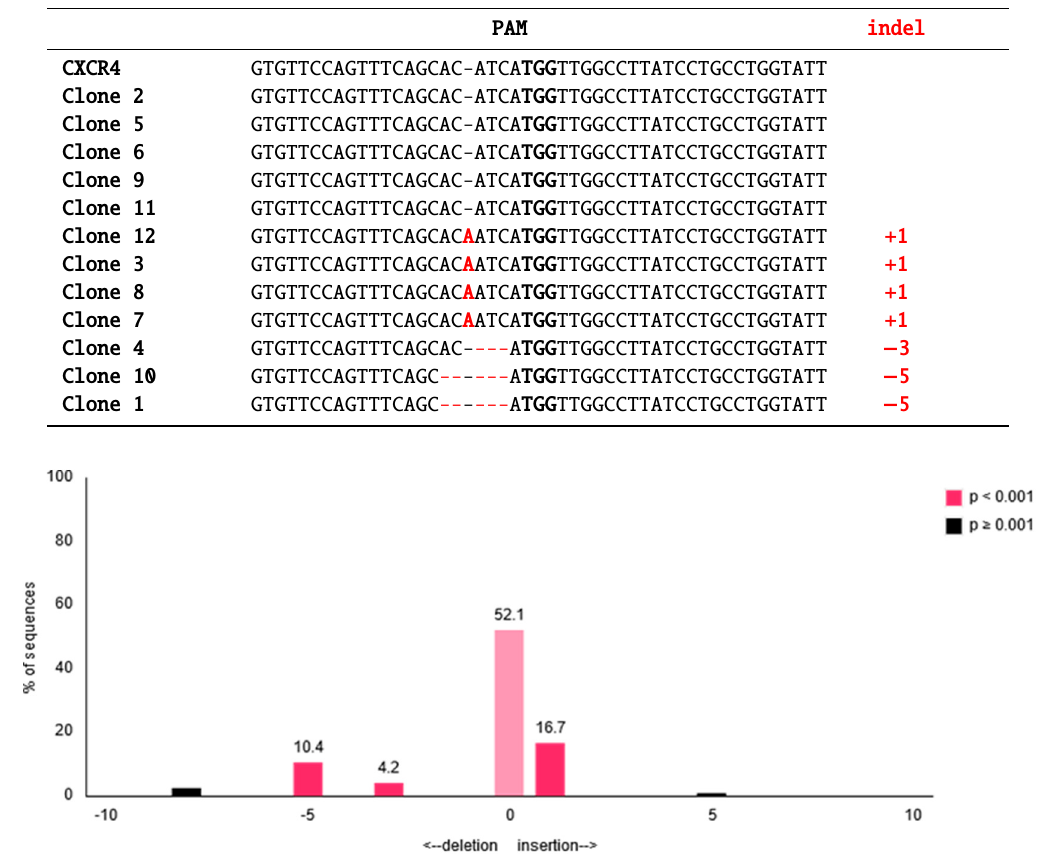
Table 4. Sequences of single PCR amplicons of synNotch-mediated gene editing via indel formation within the CXCR4 gene.